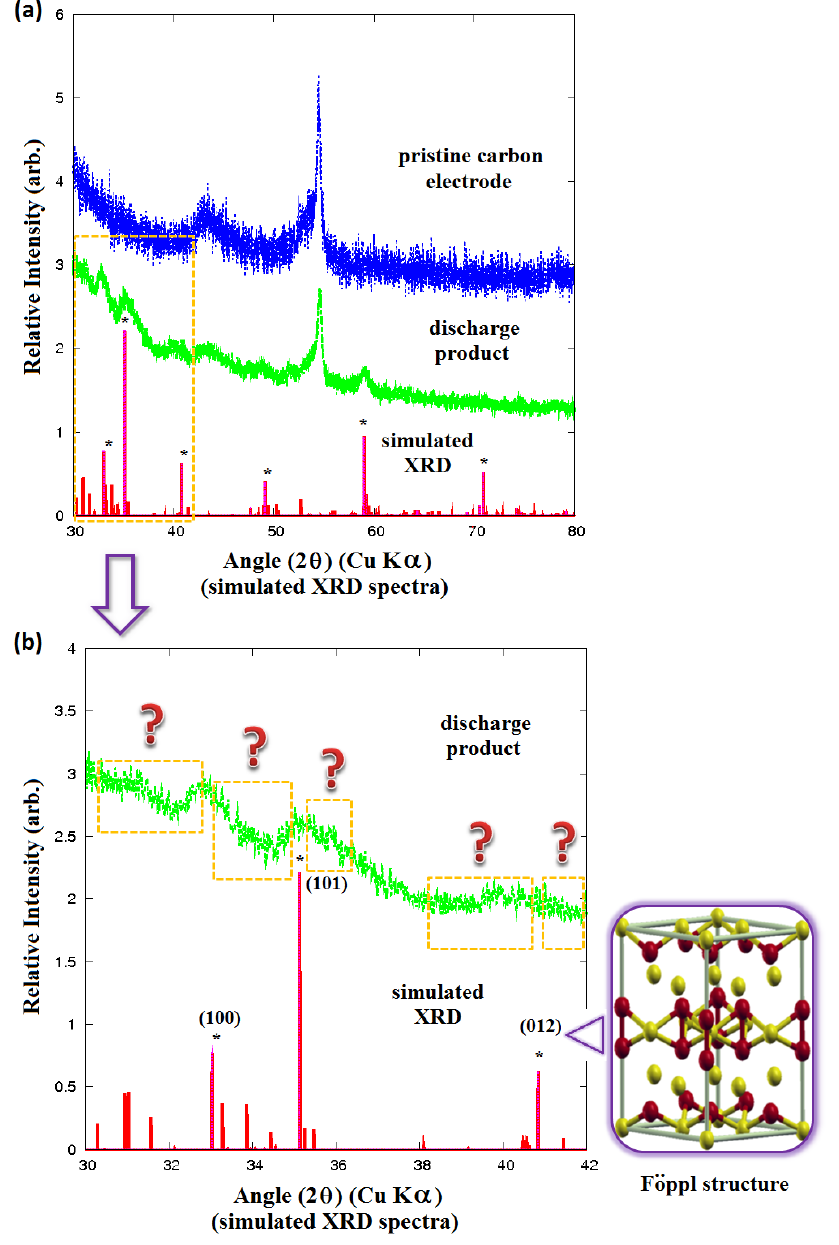
Figure 5. ( a ) The experimental XRD of a pristine carbon electrode and discharge product referenced to a simulated XRD Boltzmann weighted for a few metastable Li 2 O 2 structures from Figure 2 together with Föppl-structure marked with an *-symbol; ( b ) The enlarged region ( i.e. , 32° ≤ 2θ ≤ 42°) of the XRD data suggests the presence of Li 2 O 2 metastable